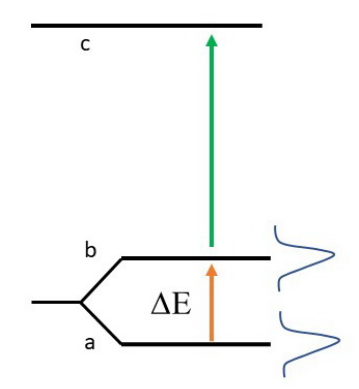
Figure 1. The proposed scheme for the axion detection. The axion induces a transition between the two Zeeman sublevels a and b , that can be tuned to the axion mass by the external magnetic field controlling the energy separation ∆ E . The absorption of the axion is then detected, exploiting a laser field that induces an electronic transition from b to the the conduction band of the matrix, whose edge is c , or, similarly, to an atomic excited